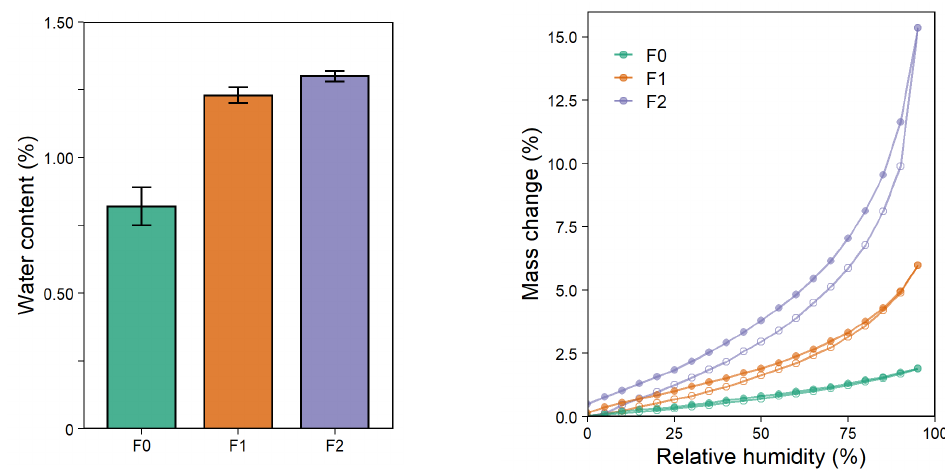
Figure 6. Karl Fischer titration results and, sorption and desorption curves of the coating films. The hollow circles correspond to the sorption step while the filled circles correspond to the desorption one .